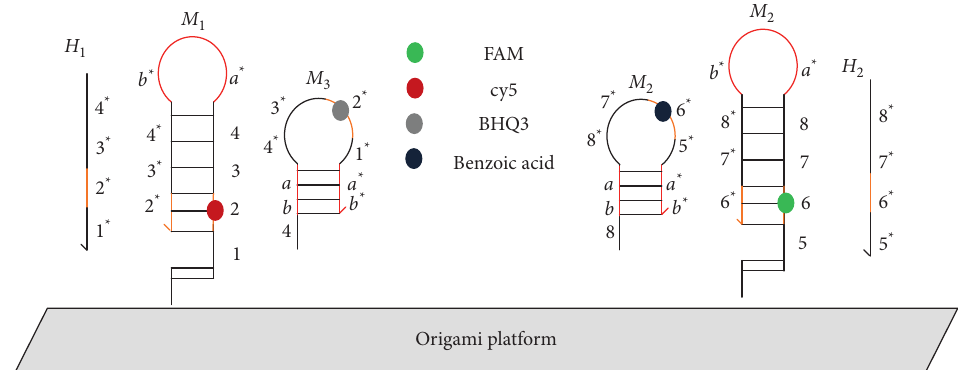
Figure 9: Materials needed to build the NAND